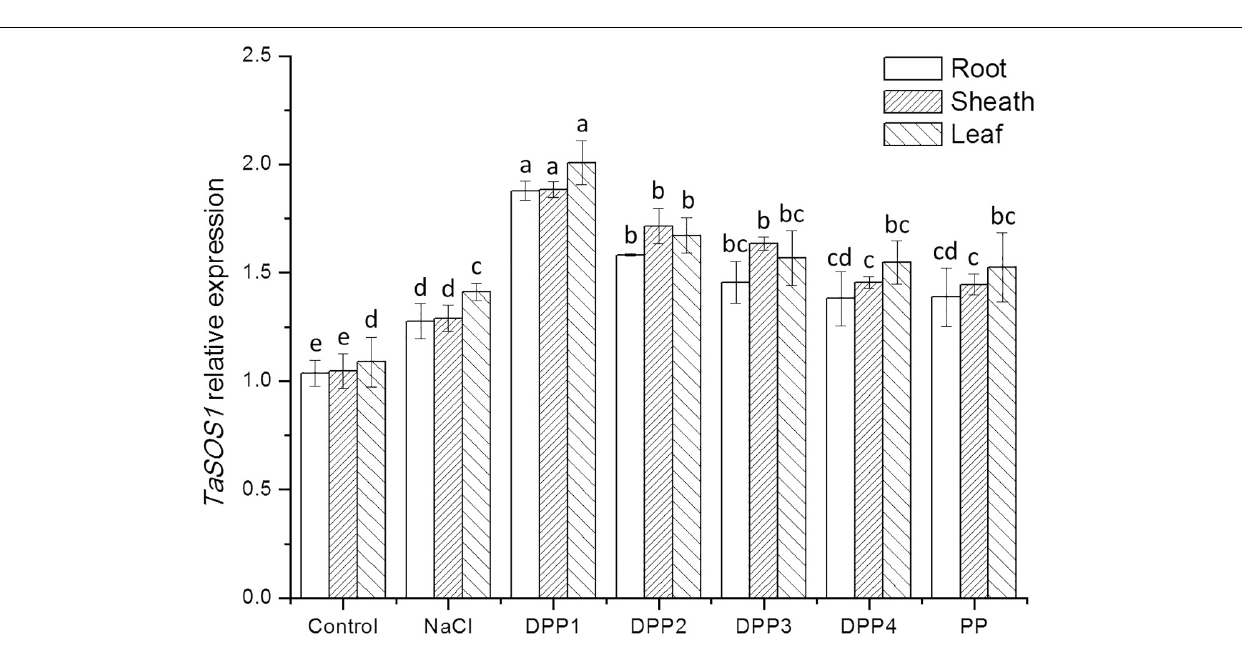
in the leaves. Recently, Kumar et al. (2017) claimed that under salt stress the increase in cytosine methylation down regulated the expression of TaHKT 2;1 and TaHKT2;3 in the salt-tolerant wheat, thereby improved its salt-tolerance